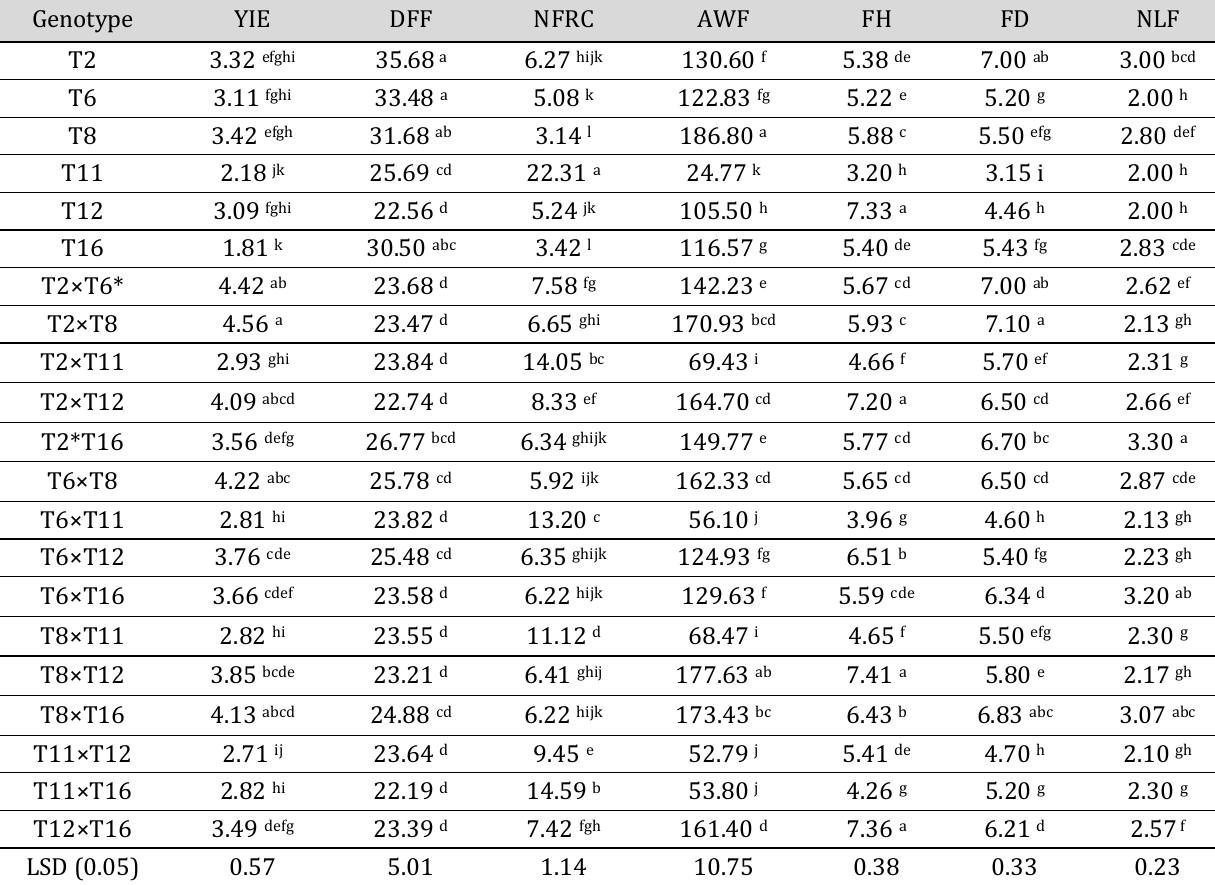
Table 3. the means of single plant yield (kg/plant), number of days until the start of flowering (days), number of fruits per cluster, fruit weight (g), fruit height (cm), fruit diameter (cm), number of locales per fruit for the studied lines and their hybrids.